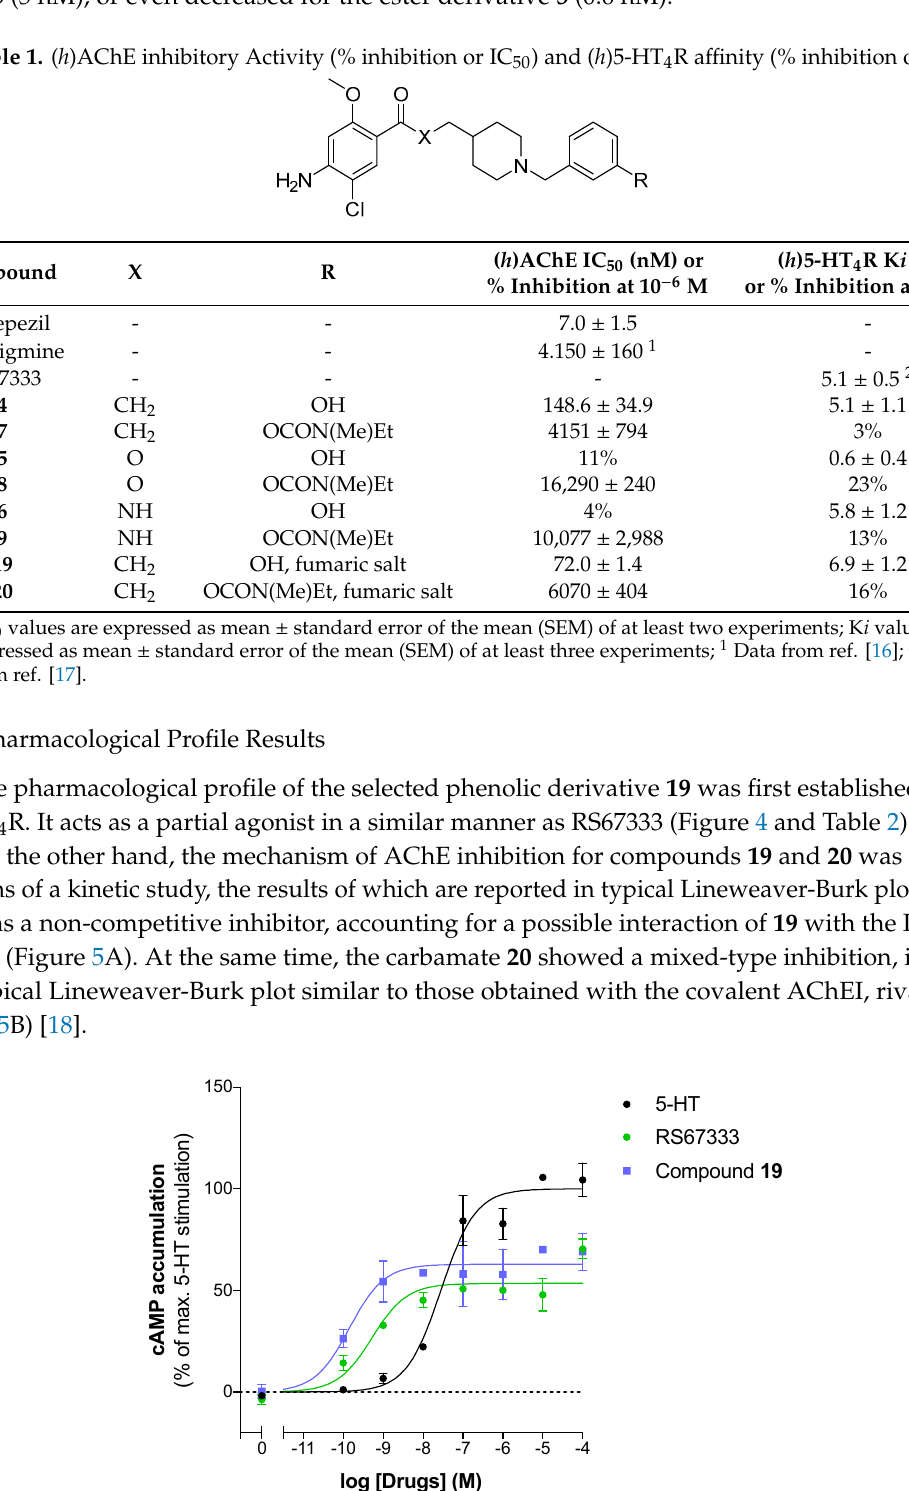
Figure 4. Pharmacological profile of RS67333 and compound 19 . Representative experiment illustrating agonist activities towards ( h )5-HT 4(a) receptors.